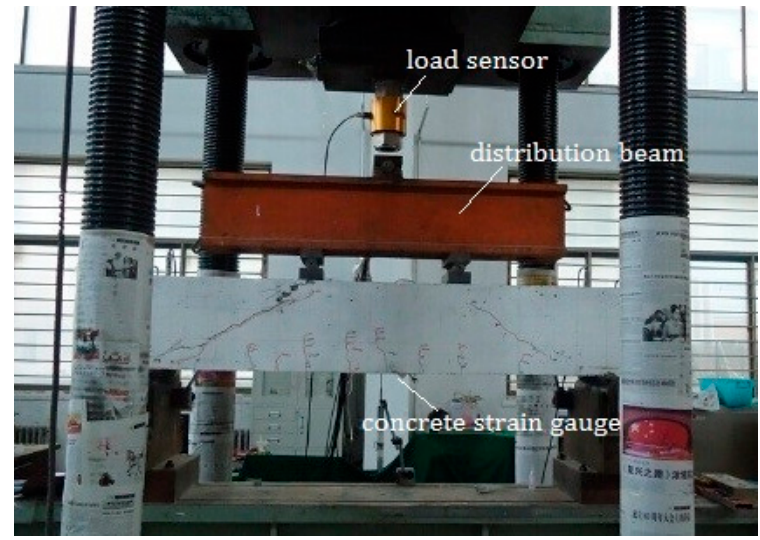
Figure 4. Test setup.